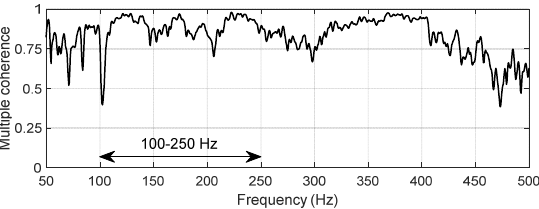
Figure 7. Multiple coherence using the 12 measured reference acceleration signals and the acoustic signal measured at the driver’s ear.